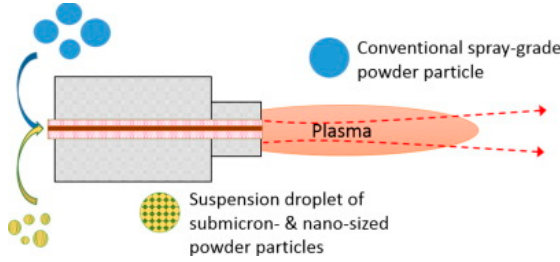
Figure 10. Schematic plasma spray coating setup and its parts [98] .